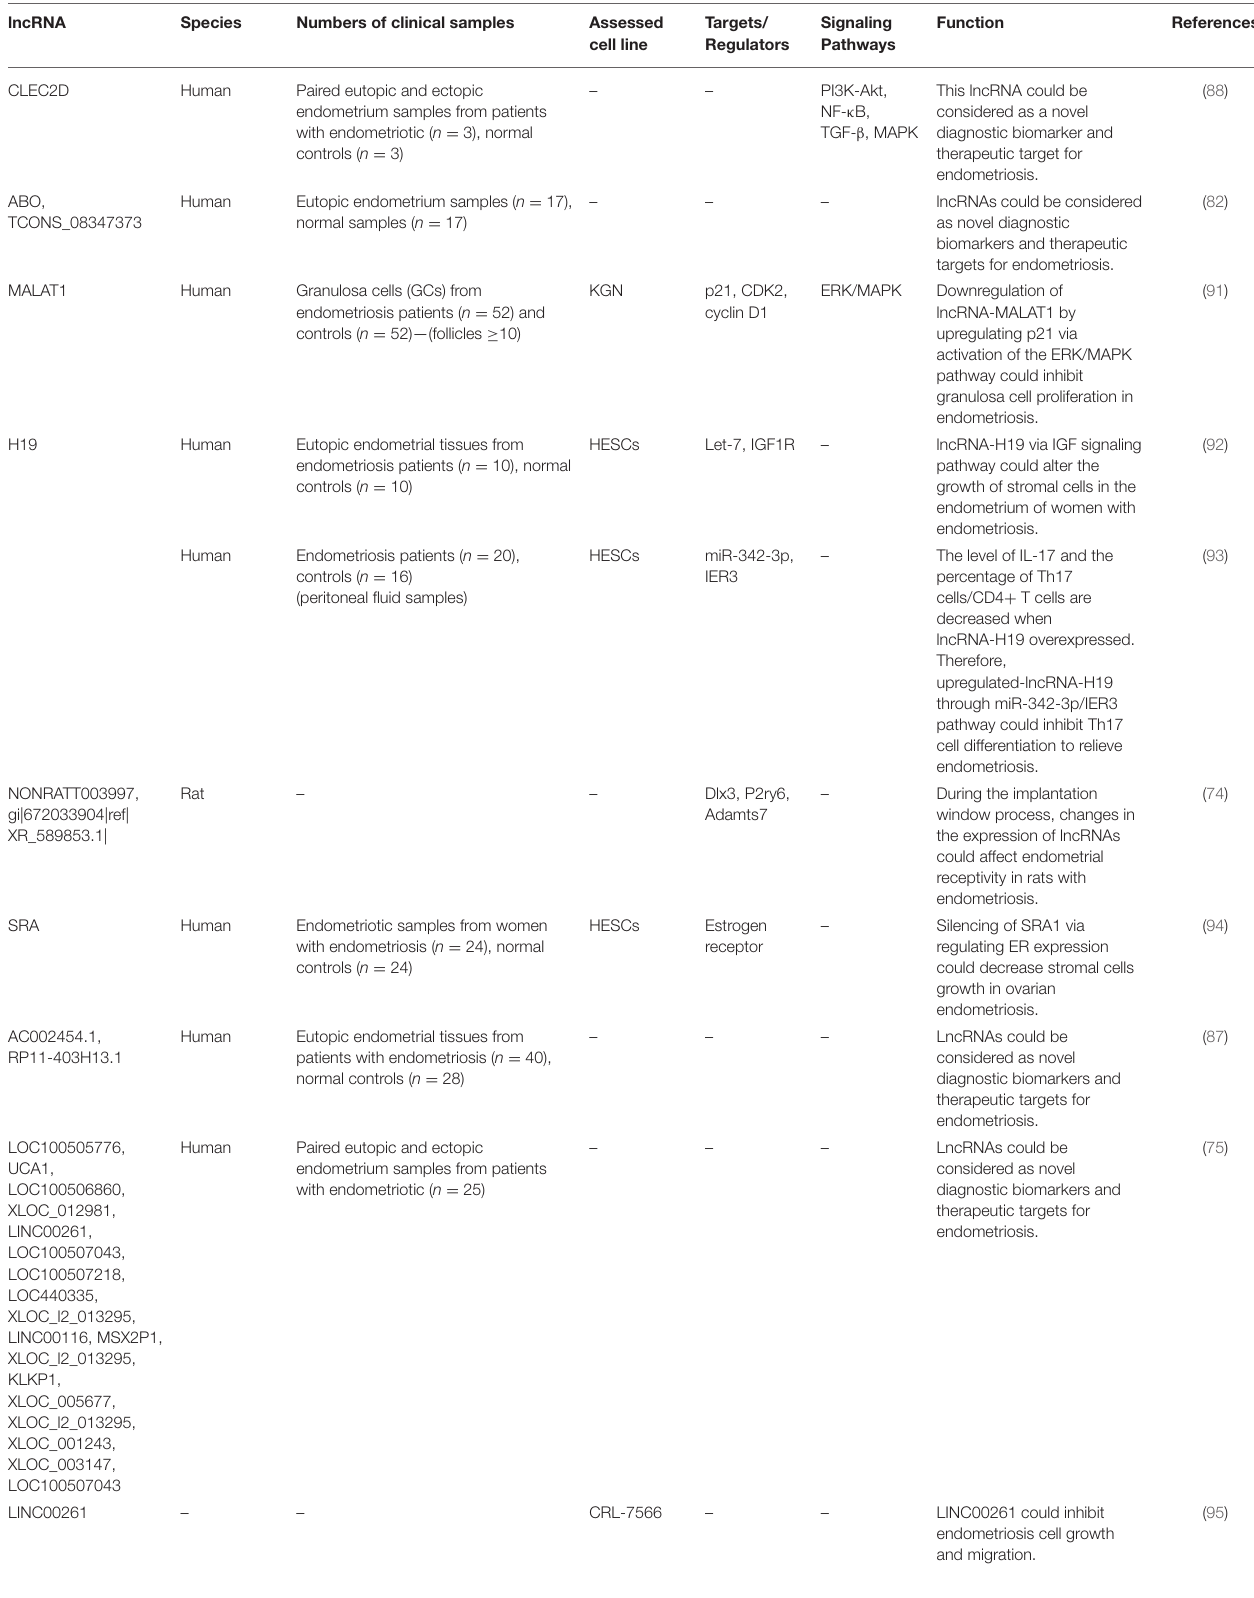
TABLE 6 | Down-regulated lncRNAs in endometriosis.